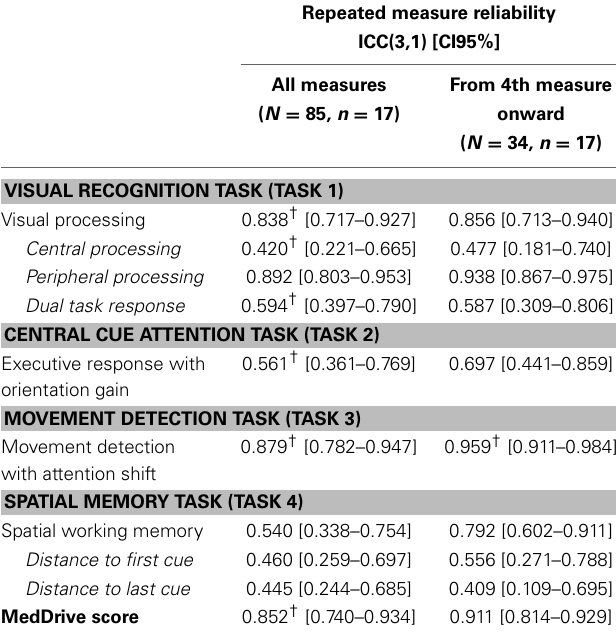
FIGURE 5 | Underlying psychophysical properties of MedDrive outputs. Columns represent outputs from MedDrive, whereas rows represent results from psychophysical and neuropsychological tests. The lighter the square, the stronger is the correlation between the two. White stars correspond to a significant level of p < 0 . 05 unadjusted for multiple testing. Visual processing score was significantly associated to all visual processing measures except for biological motion detection. The output from the movement detection task (Task 3) was associated to visual processing, visual search, and to mental flexibility (WCST). Interestingly enough, when all these measures were combined in a single score (MedDrive score) this score was then highly correlated to visual search. This leads us to believe that the MedDrive score is a good indicator of a person’s ability to detect and interpret peripheral visual stimuli. SOA, stimuli onset asynchrony; R 2 , coefficient of determination; WCST, Wisconsin card-sorting